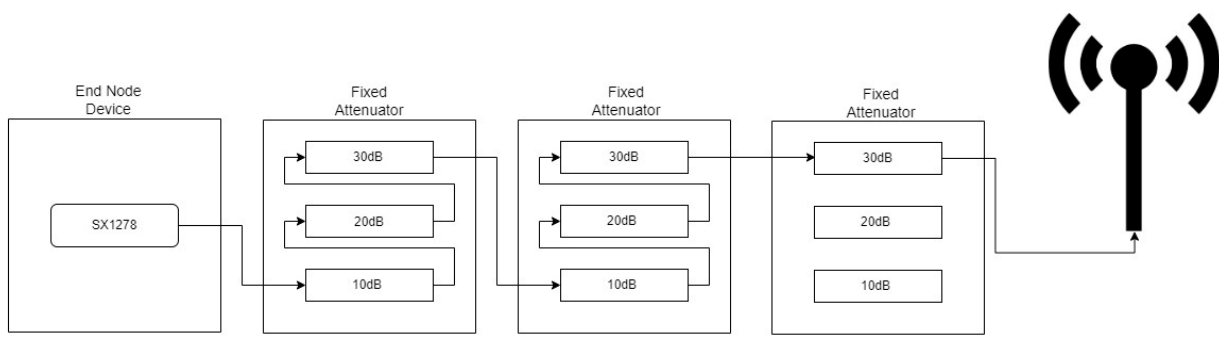
Figure 9. Block diagram of attenuators used to simulate path loss in Figure 8.